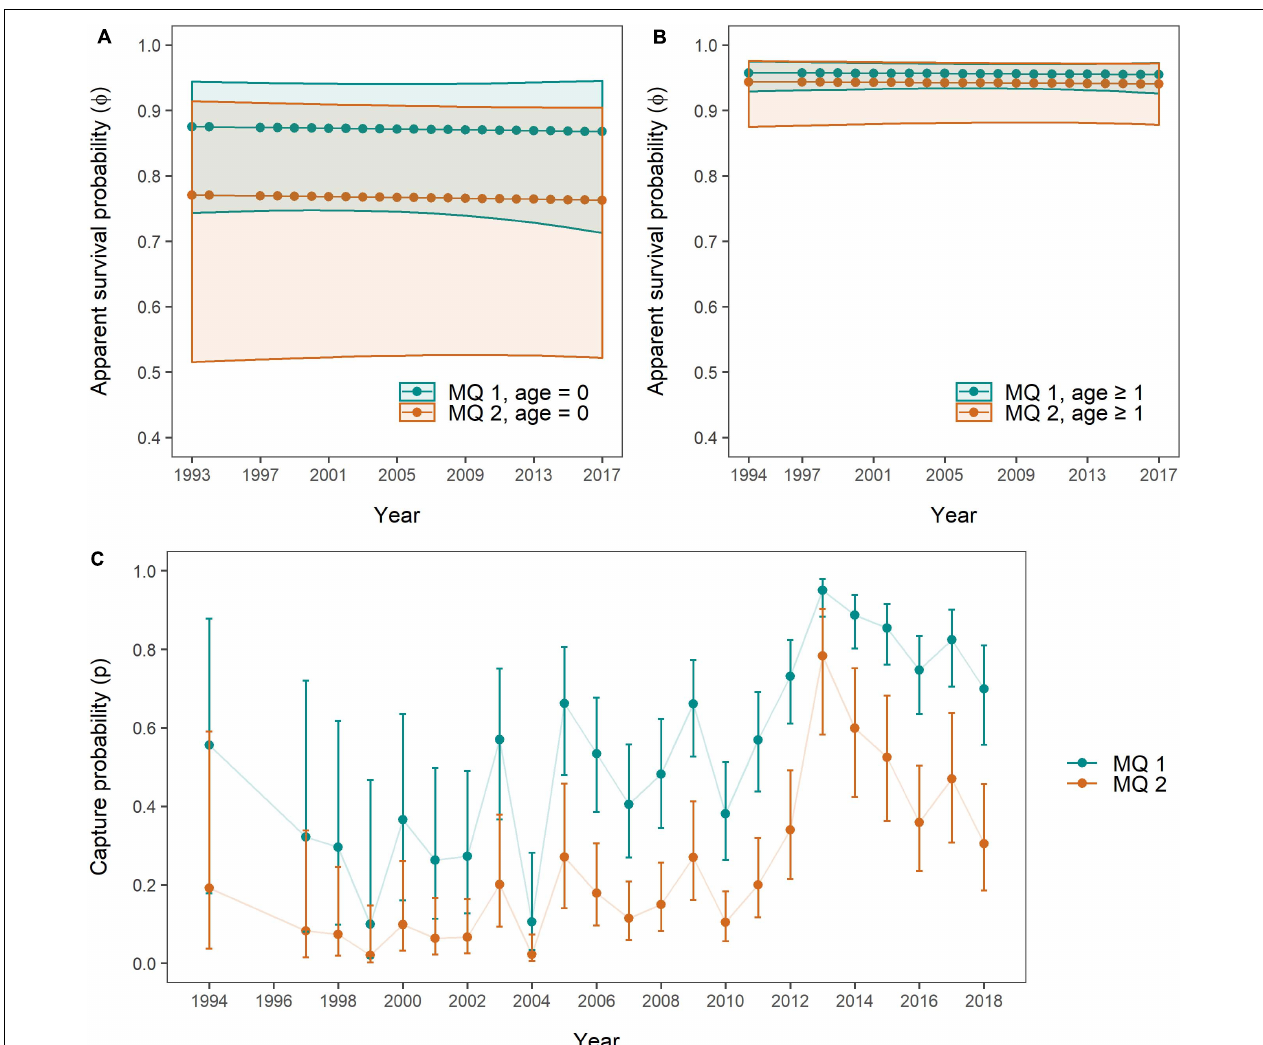
FIGURE 7 | Apparent survival probabilities of MQ-1 ( n = 92, turquoise) and MQ-2 individuals ( n = 47, orange) for (A) age class “0” and (B) age class “1 or older,” as well as (C) capture probabilities per mark severity group as obtained through the Mark Severity model. 95% confidence intervals are presented as polygons (A,B) and error bars (C) in the respective